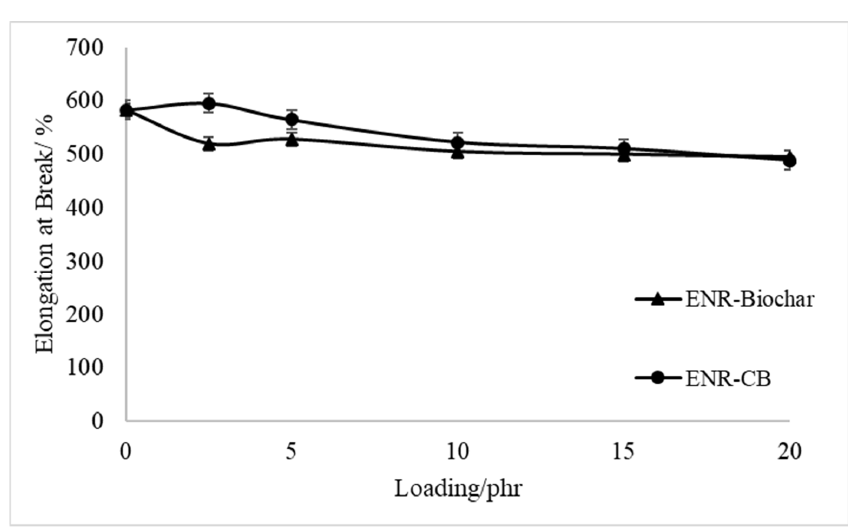
Figure 5. Elongation at Break of Biocomposites.